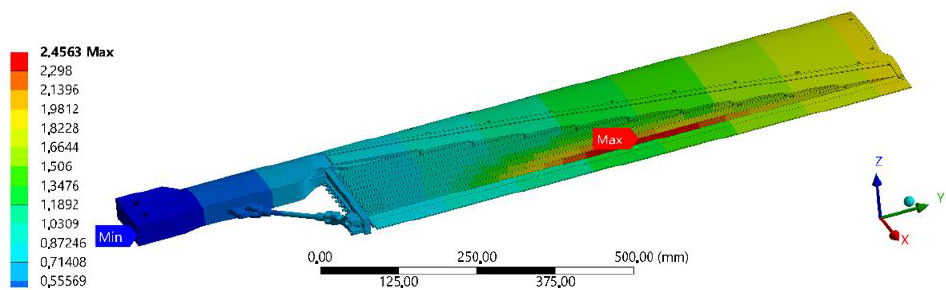
Figure 4. Finite element simulation (ANSYS) of the demonstrator under aerodynamic and centrifugal loads. Shown are deformations.